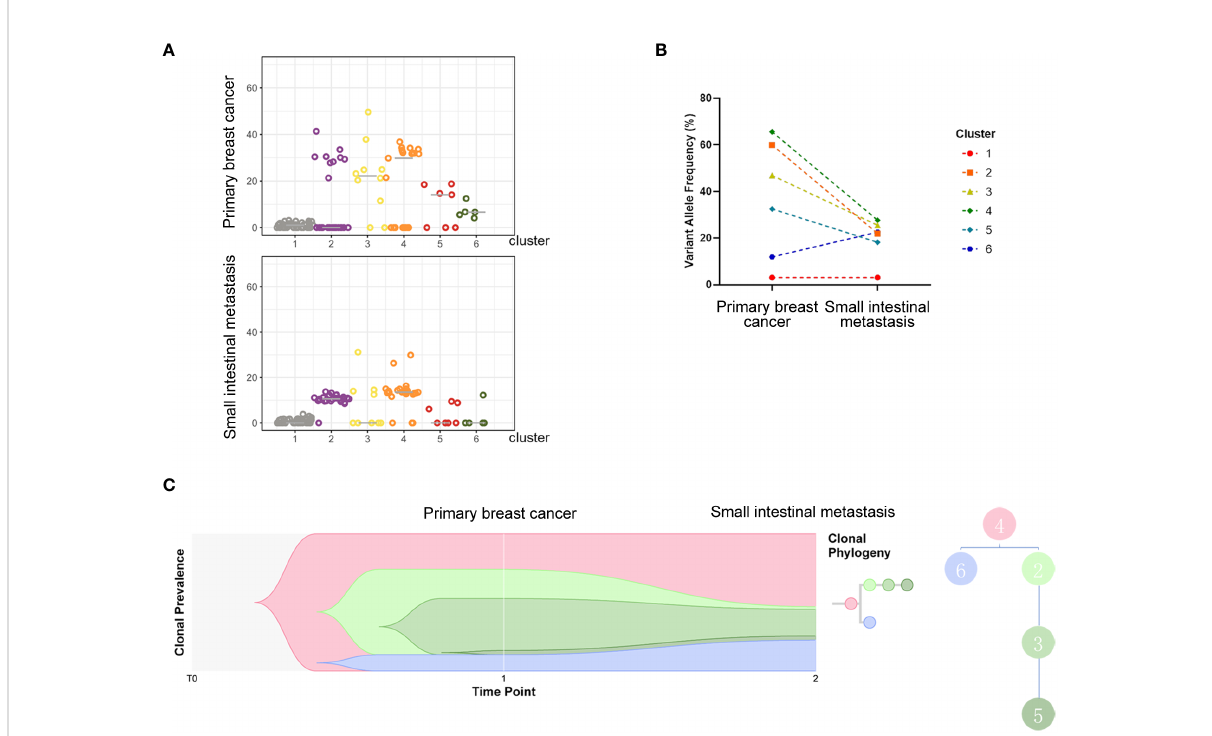
FIGURE 4 Analysis of subclones indicating evolutionary relations of clusters. All detected mutations of the two samples were clustered into 6 clones. The variant allele fraction (VAF) distribution of each detected mutation in different samples is shown in (A) , and changes in the average VAF of detected mutations between subclones of the two samples are exhibited in the charts of (B) . (C) indicates the evolutionary relations of